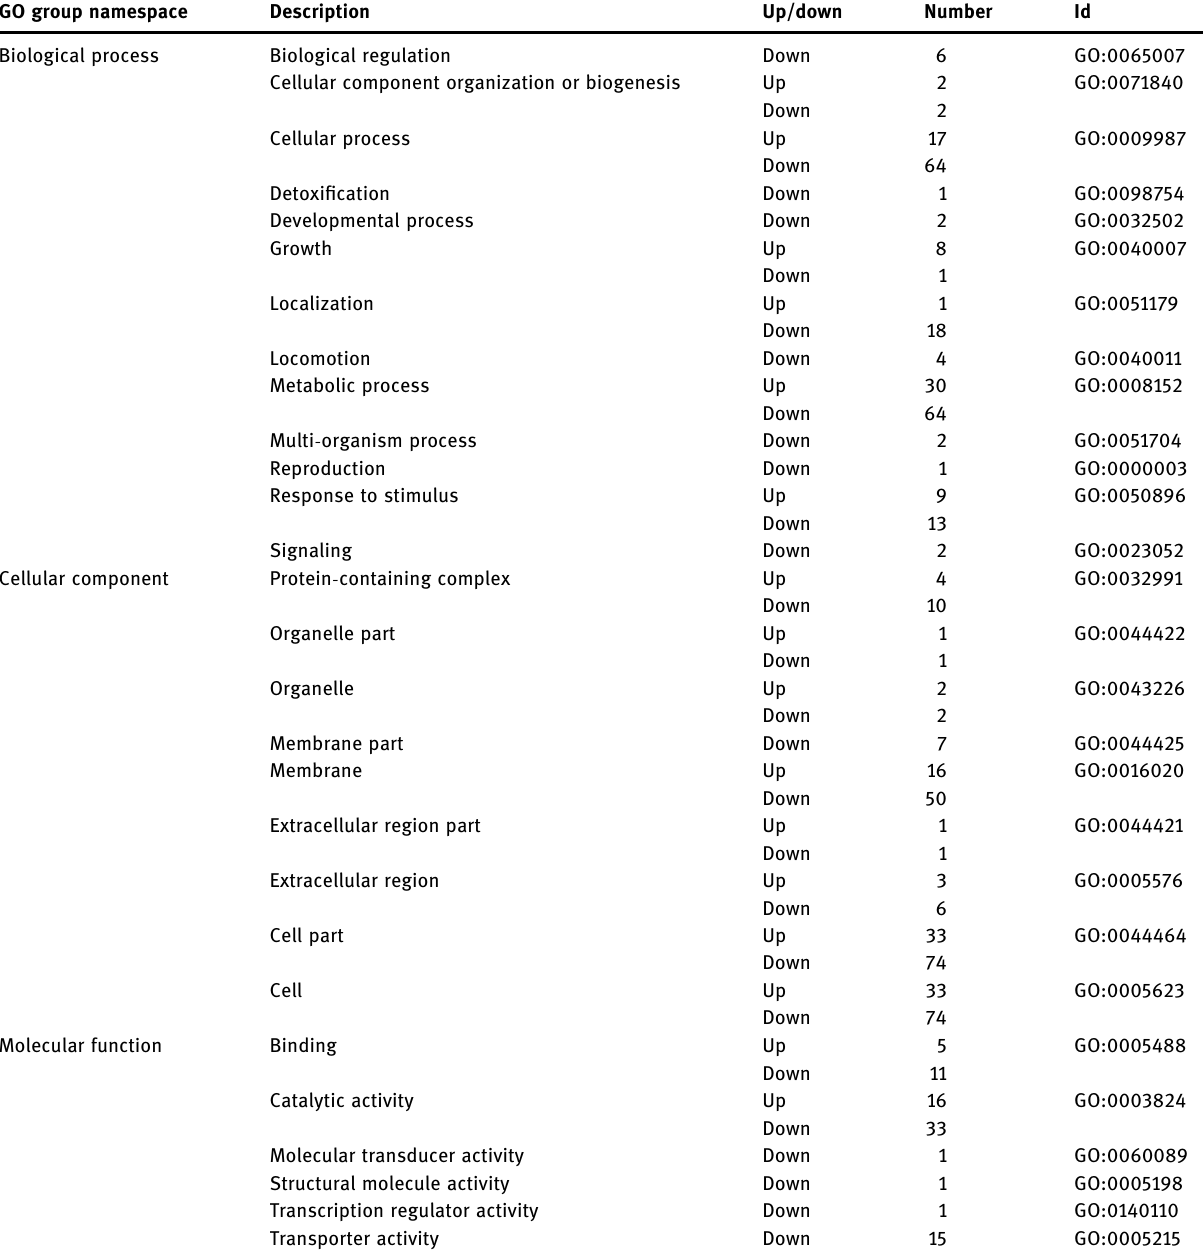
Table 1: GO functional analysis in three groups: control ( SX4 - CK ) vs salt - treated ( SX4 ) GO enrichment GO group